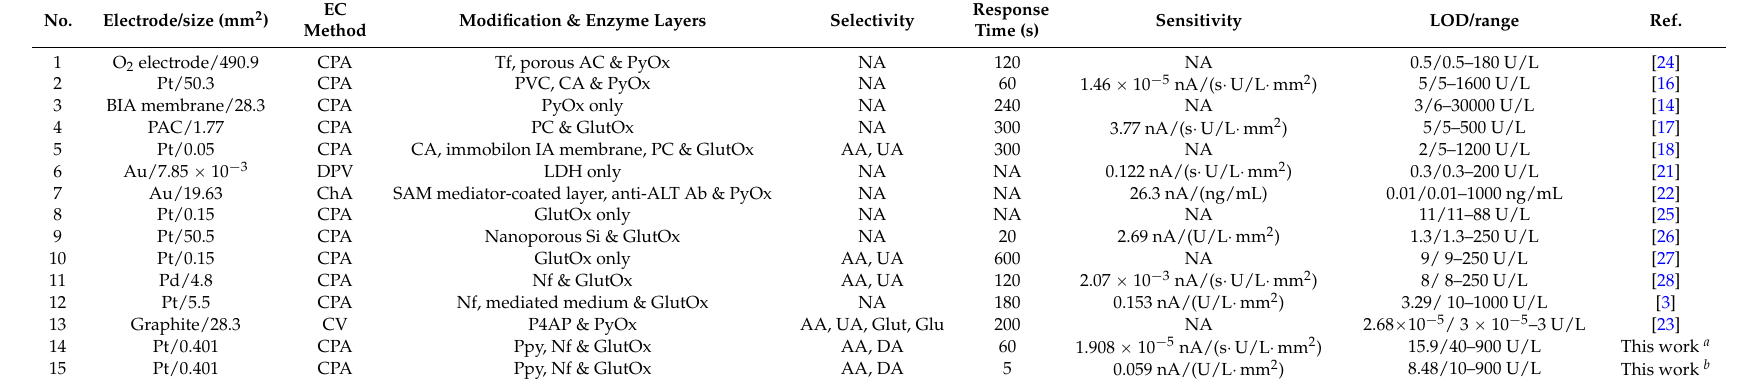
Table 1. Recently reported electrochemical biosensors for the detection of alanine aminotransferase and their figures of